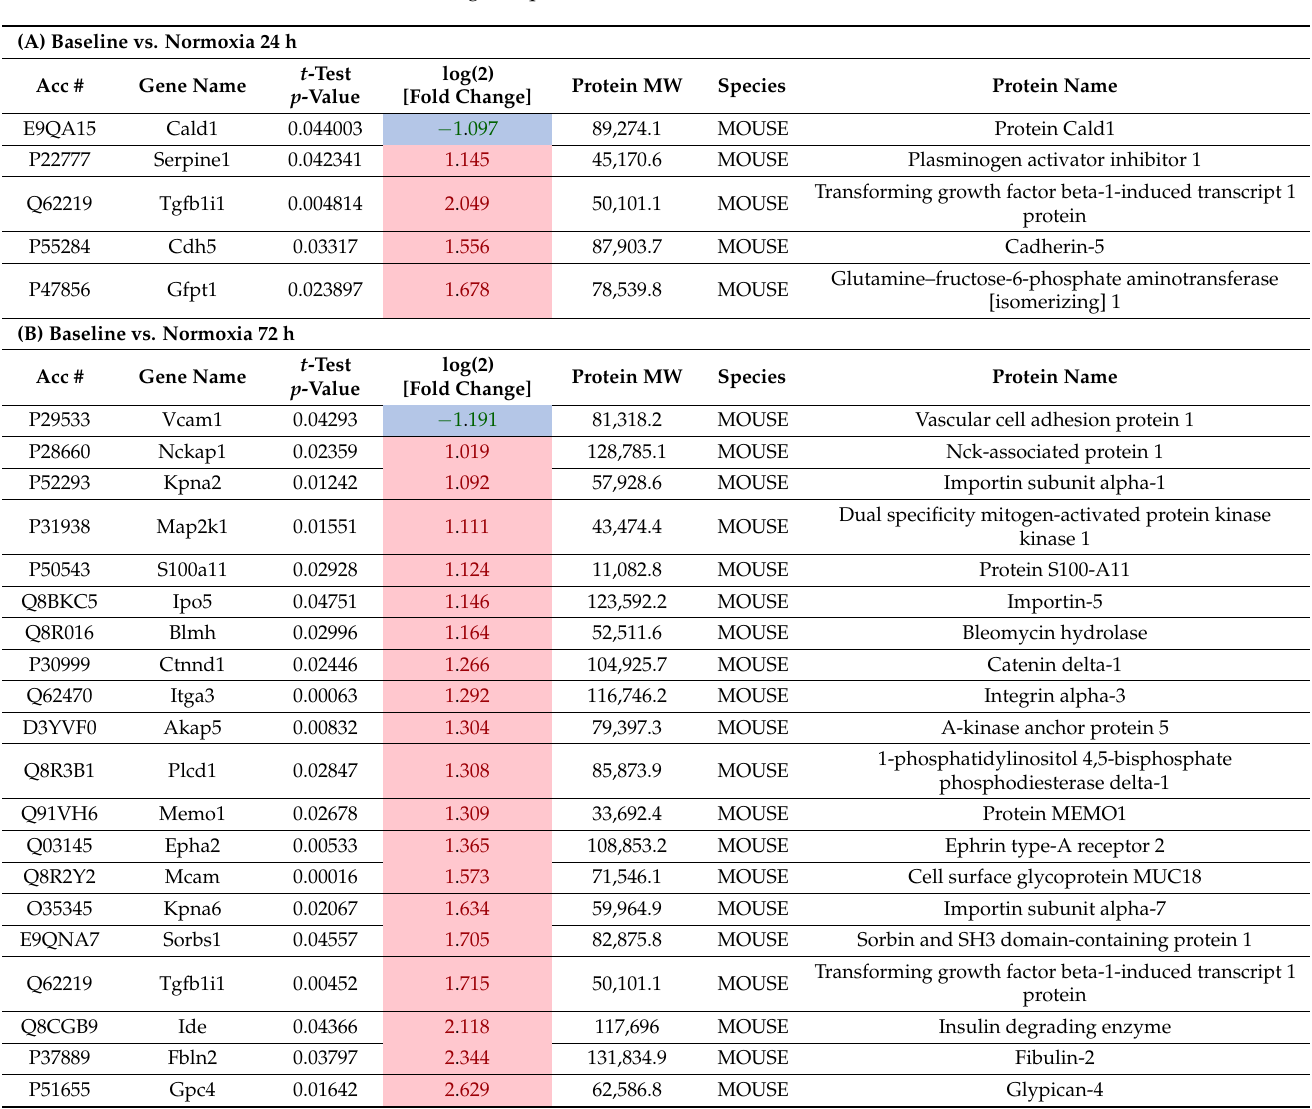
Table 3. Differentially expressed proteins (DEPs) after 24 h and 72 h exposure to normoxia (21% O 2 ) compared to baseline (0 h). Murine lung endothelial cells were exposed for 24 h ( A ) and 72 h ( B ) to 21% O 2 . Semi-quantitative proteomic analysis revealed statistically significant changes in protein expression (blue: downregulated DEPs; red: upregulated DEPs). Results are log(2) fold changes compared to baseline (=start of experiment, Time = 0). Statistical evaluation: two-sample t -test assuming unequal variances.